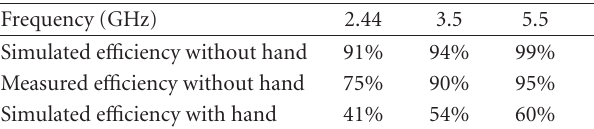
Table 2: Hand e ff ect on the e ffi ciency of the proposed